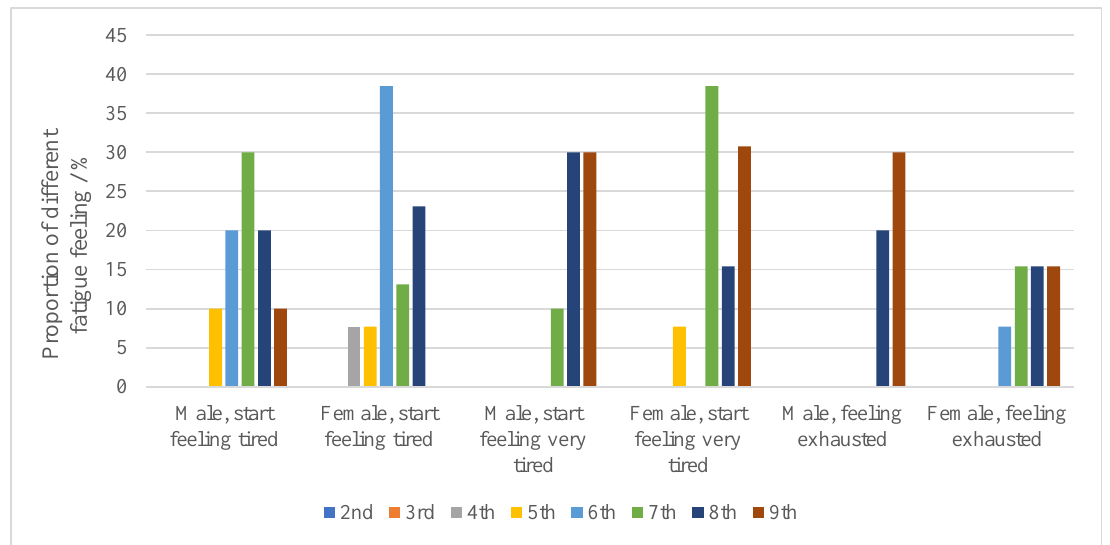
Figure 14. Fatigue feeling survey during walking upstairs of the young participants.